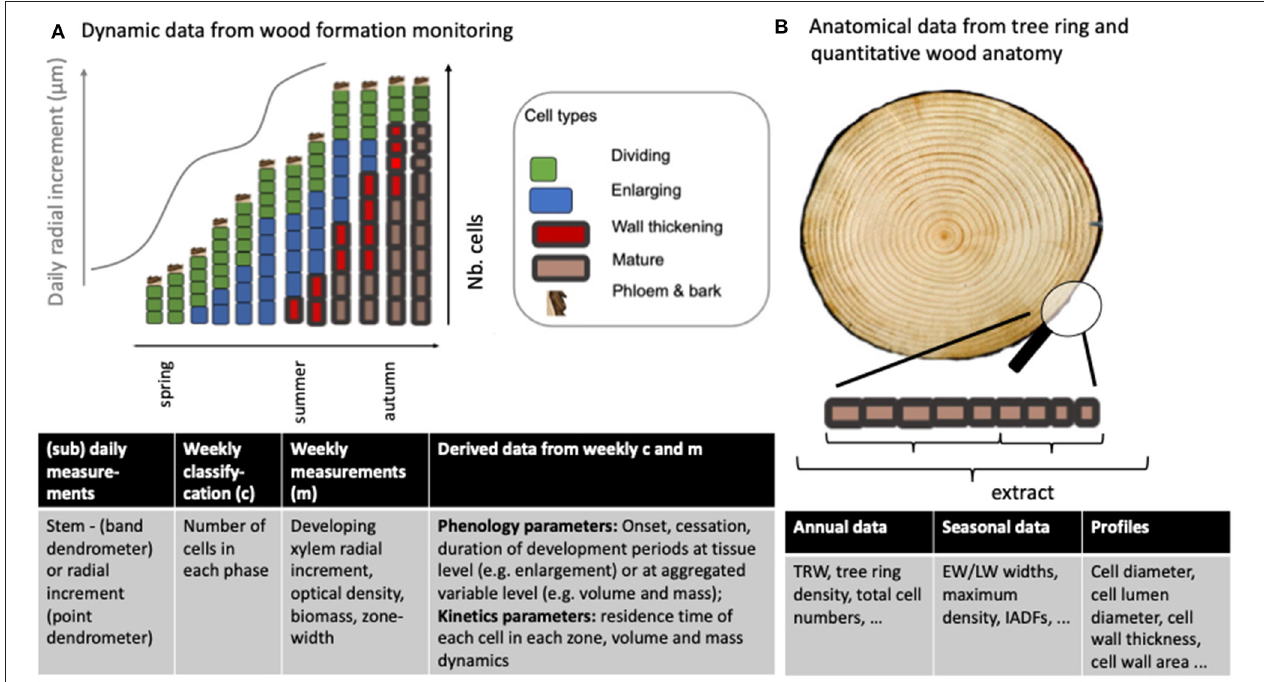
FIGURE 4 | (A) Dynamic (B) static observations useful for wood formation model interrogation. (A) : (sub)-daily radial increment measurements are taken using dendromenters. Weekly classification requires staining methods, light microscopy and a human to identify and count cells of a given type. Weekly measurements can be semi-automated and do not necessarily involve the identification of specific cell phases. Weekly cell counts and measurements can be used to derive observations such as a period of presence/absence of a cell type (at the xylem tissue level) or the residence time of each cell in each phase (at the cell level, but also possible to derive at the tissue level). Tree disk image from Cuny et al.